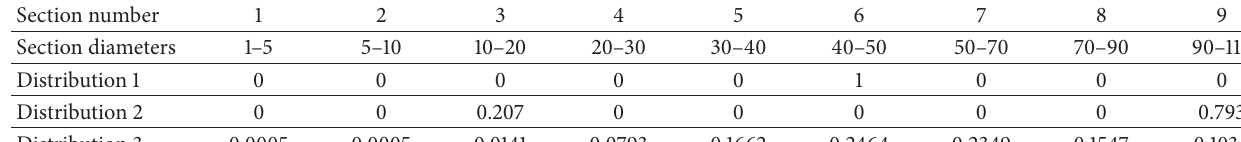
Table 1: The sectional diameters 𝑑 𝑗 ( 𝜇 m) and initial droplet size distributions.